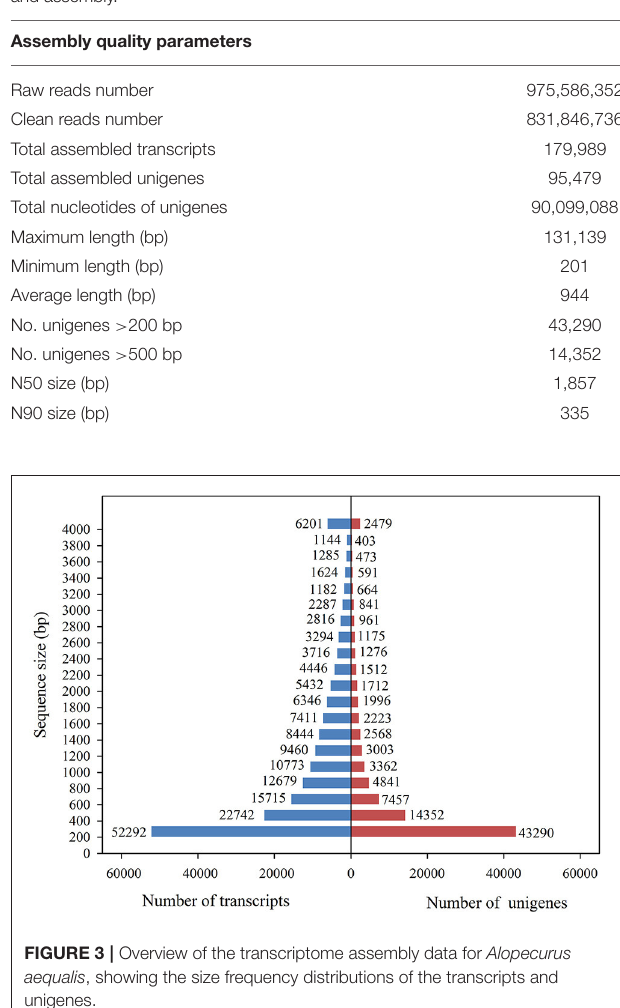
TABLE 2 | Summary statistics of Alopecurus aequali transcriptome sequencing and assembly.